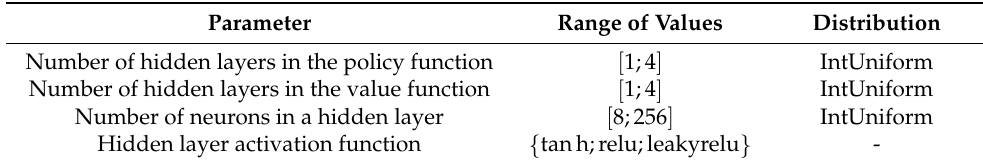
Table A2. All MLP hyper-parameters optimized in this work.